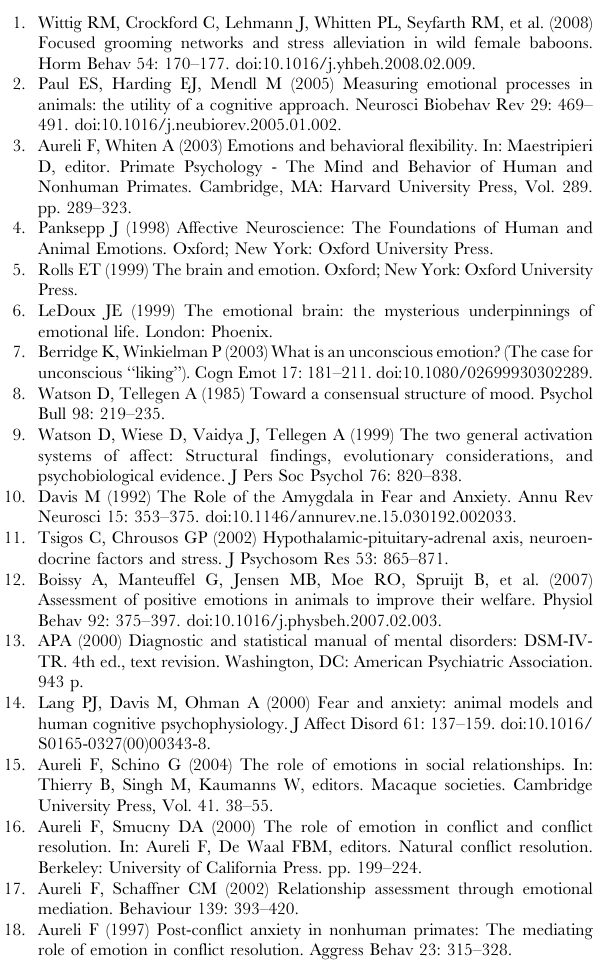
Table S1 Individual-specific state variables of the model entities. Table S2 General model parameters. Table S3 Schedule times depending on performed, received or observed behavior.